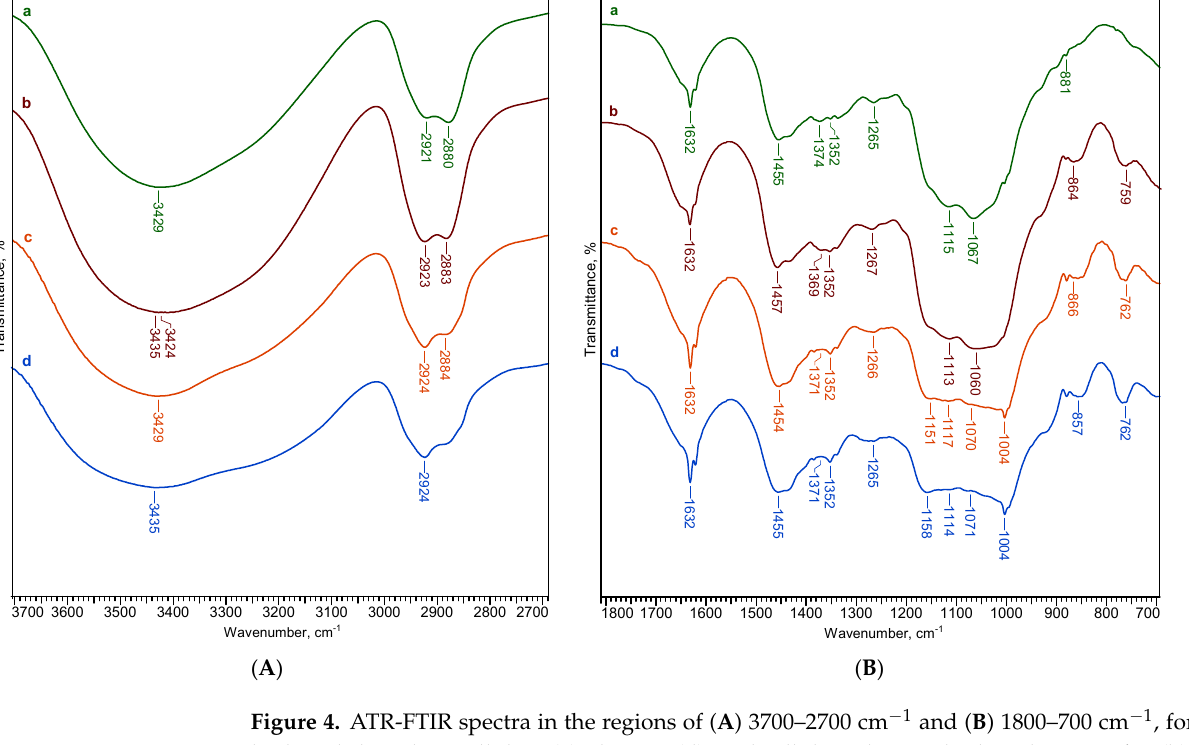
Figure 4. ATR-FTIR spectra in the regions of ( A ) 3700–2700 cm − 1 and ( B ) 1800–700 cm − 1 , for the hydrogels based on cellulose (a), dextran (d), and cellulose-dextran hydrogels: CD50/50 (b) and CD25/75 (c).